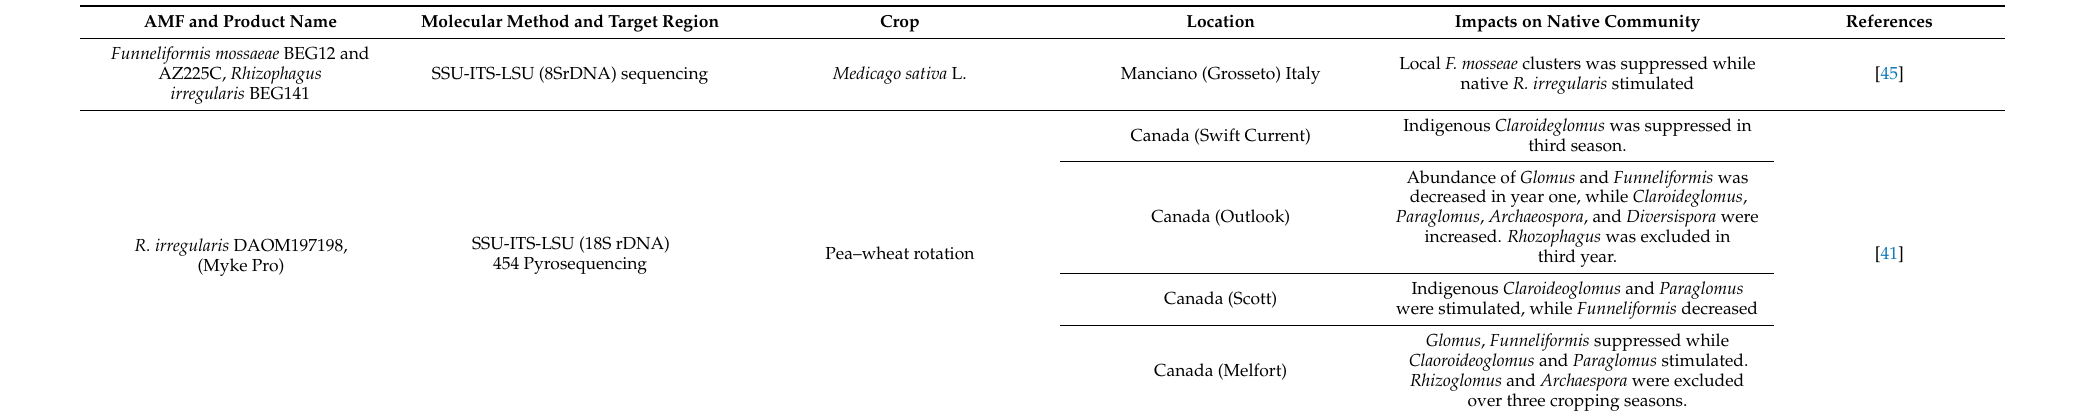
Table 2. Impact of introduced AMF on indigenous community. Criteria for selection were experiment in field and use of molecular tools to trace or monitor AMF